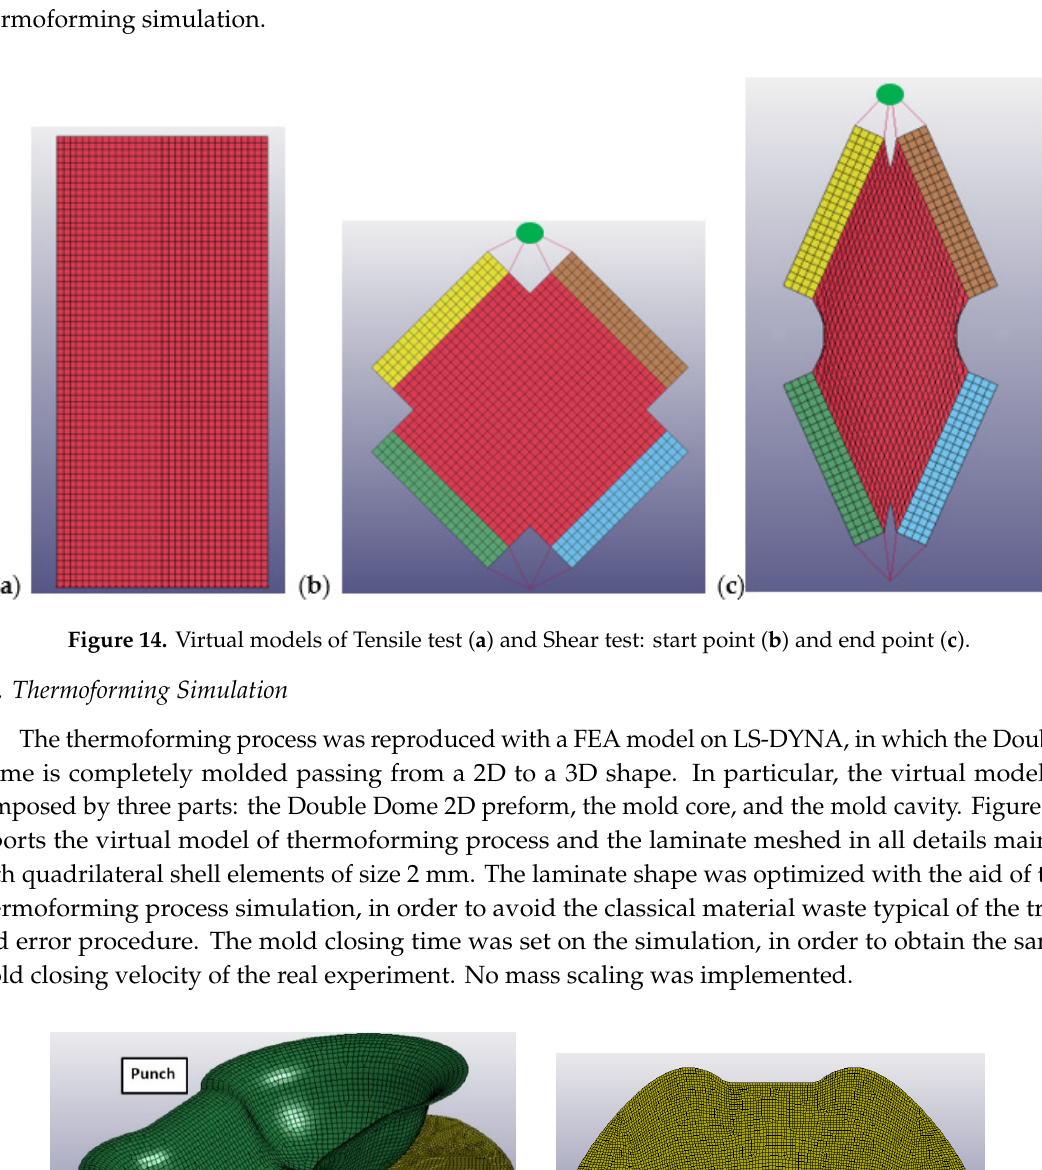
Figure 14. Virtual models of Tensile test ( a ) and Shear test: start point ( b ) and end point ( c ).